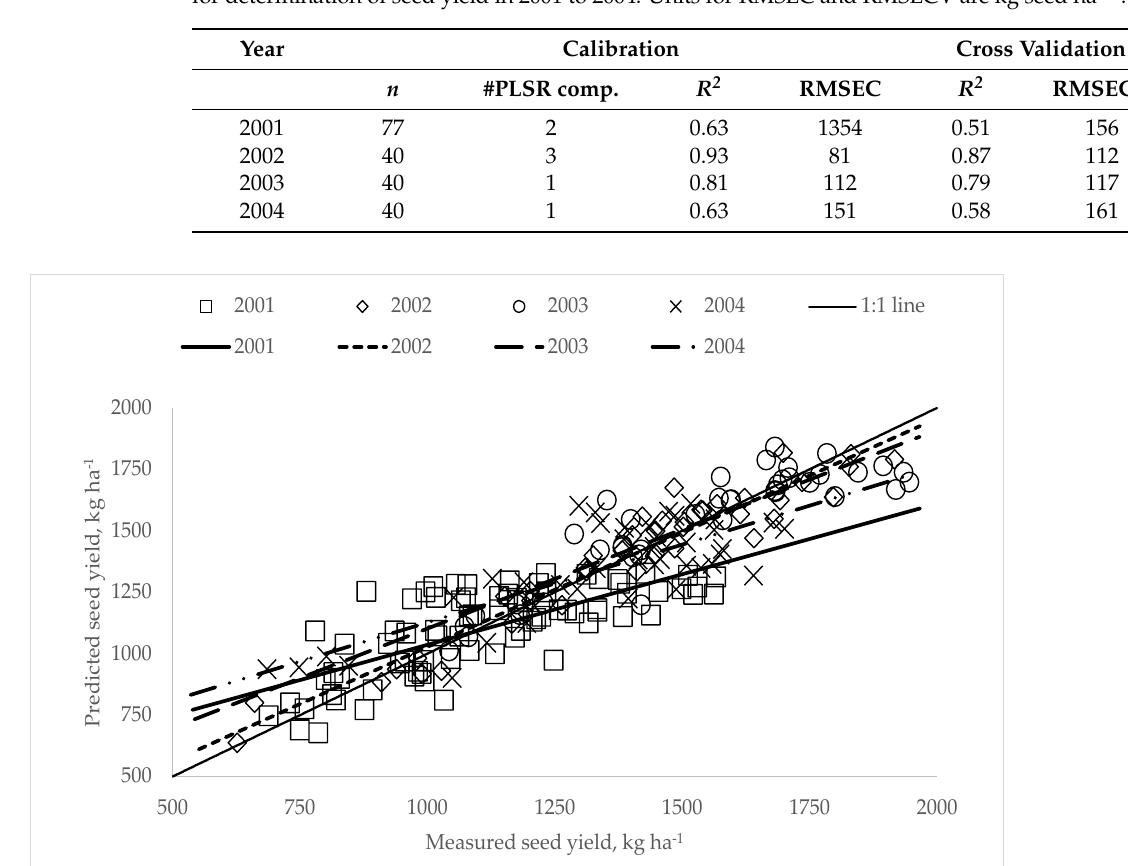
Figure 6. Measured vs. predicted seed yield for the four years, including the best linear fit and a 1:1 line.